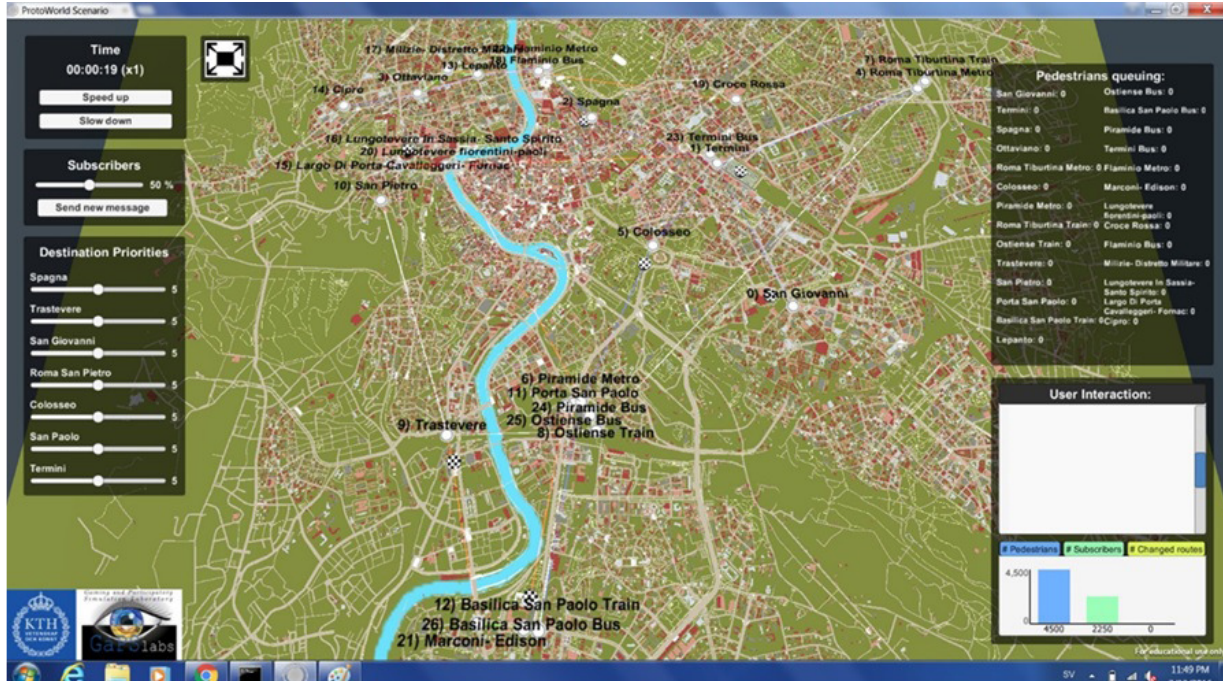
Figure 1. Macro view of the game in